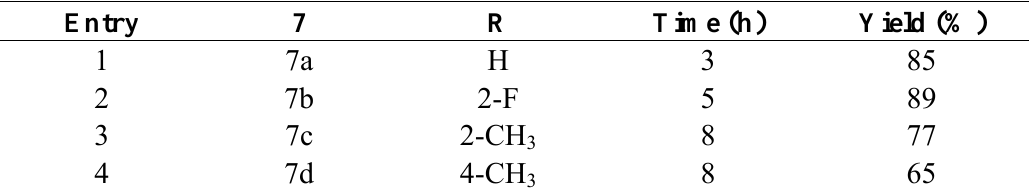
Table 2. Synthesis of imine 7